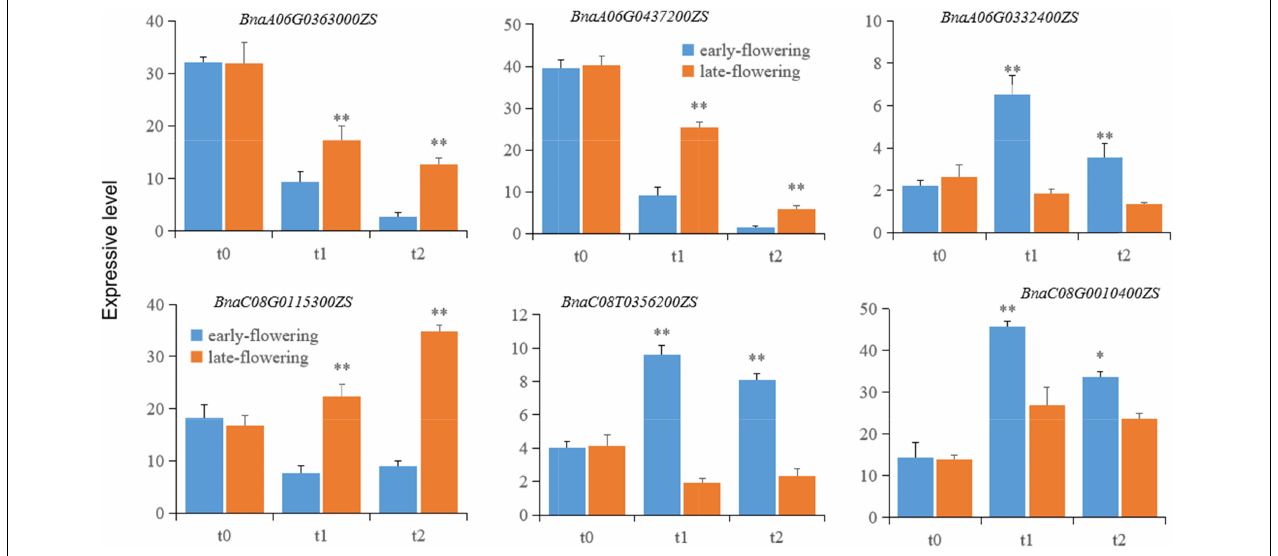
FIGURE 5 | The expression of putative genes related to flowering time in early- and late-flowering B. napus varieties during vernalization. Each candidate gene is labeled in the upper part of each panel. t0, t1, and t2 represent unvernalization and vernalization treatments for 20 and 40 days. Single and double asterisks ( ∗ , ∗∗ ) indicate statistical significance relative to the control at p < 0.05 and p < 0.01, respectively. The error bars represent the standard